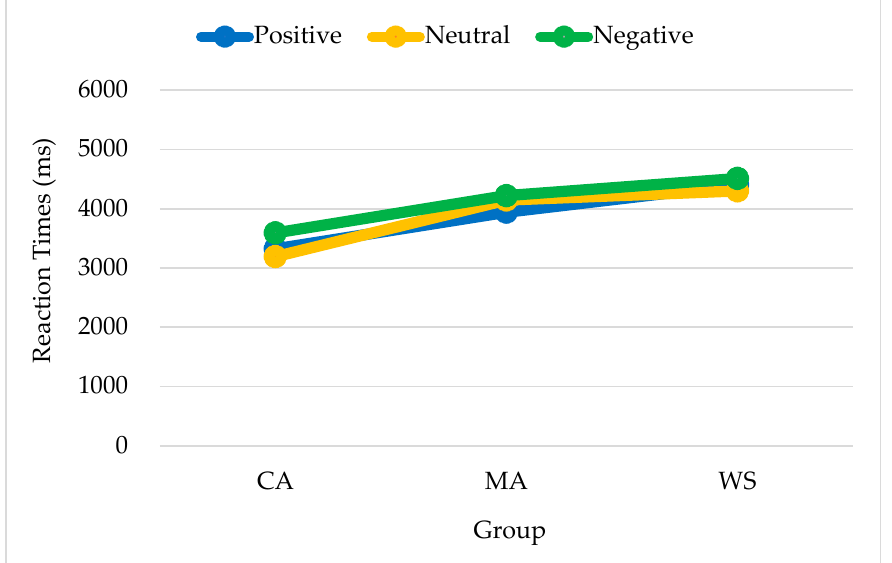
Figure 6. Reaction times of the responses to negative primes by emotion target type and group. Note. CA, chronological age-matched controls; MA, mental age-matched controls; WS, participants with Williams syndrome.